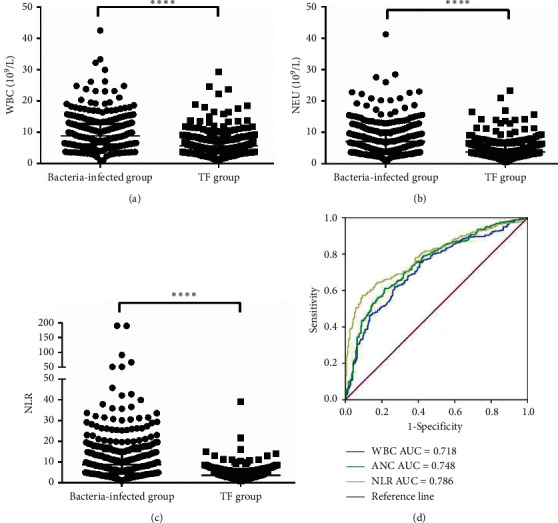
Inflammatory markers (WBC, NEU and NLR) between bacteria-infected group (N = 311) and TF group (N = 277) in NNLCPs with fever. The differences of WBC (a) and NEU (b) levels and NLR (c) between bacteria-infected group (N = 311) and TF group (N = 277). The horizontal lines represented the median. Statistical significance was calculated with Mann–Whitney test. (d) ROC curves of the sensitivity and specificity for WBC, NEU, and NLR. ROC curves were calculated predicting the absence or presentation of infection in febrile NNLCPs. ∗∗∗∗p < 0.0001; WBC: white blood cell; NEU: neutrophil; NLR: neutrophil-to-lymphocyte ratio; TF: tumor fever; AUC: area under the ROC curve; NNLCPs: nonneutropenic lung cancer patients.